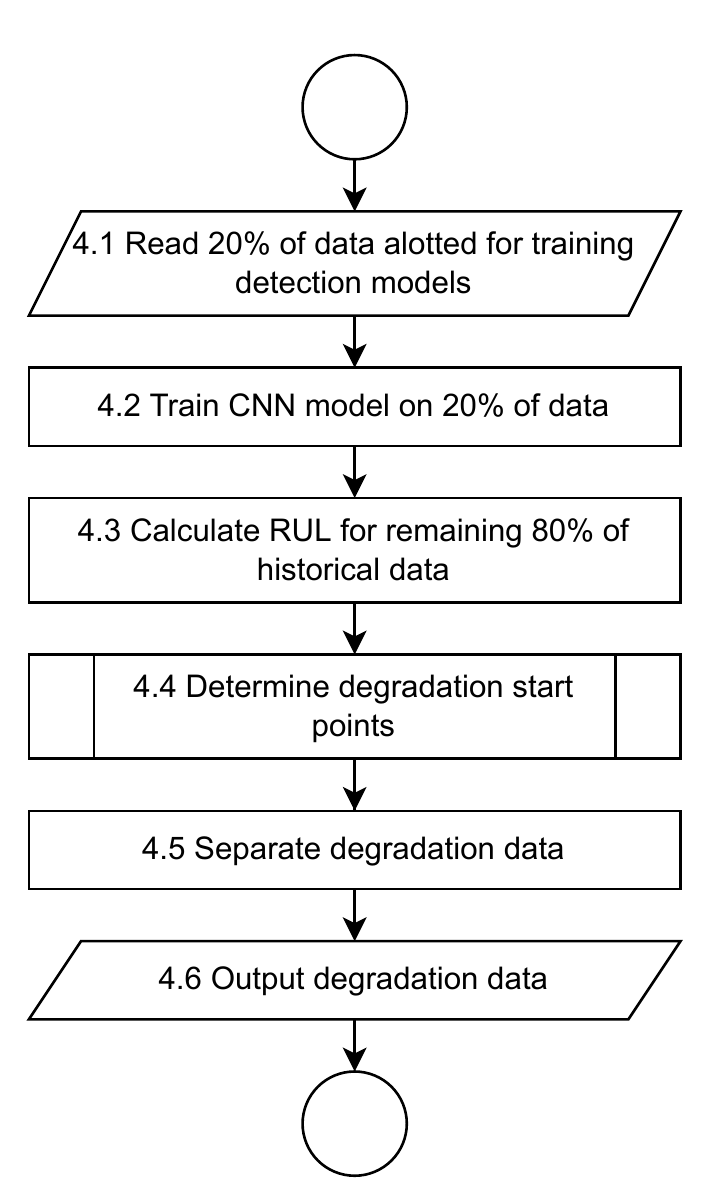
Figure 13. Proposed method for preparation of degradation